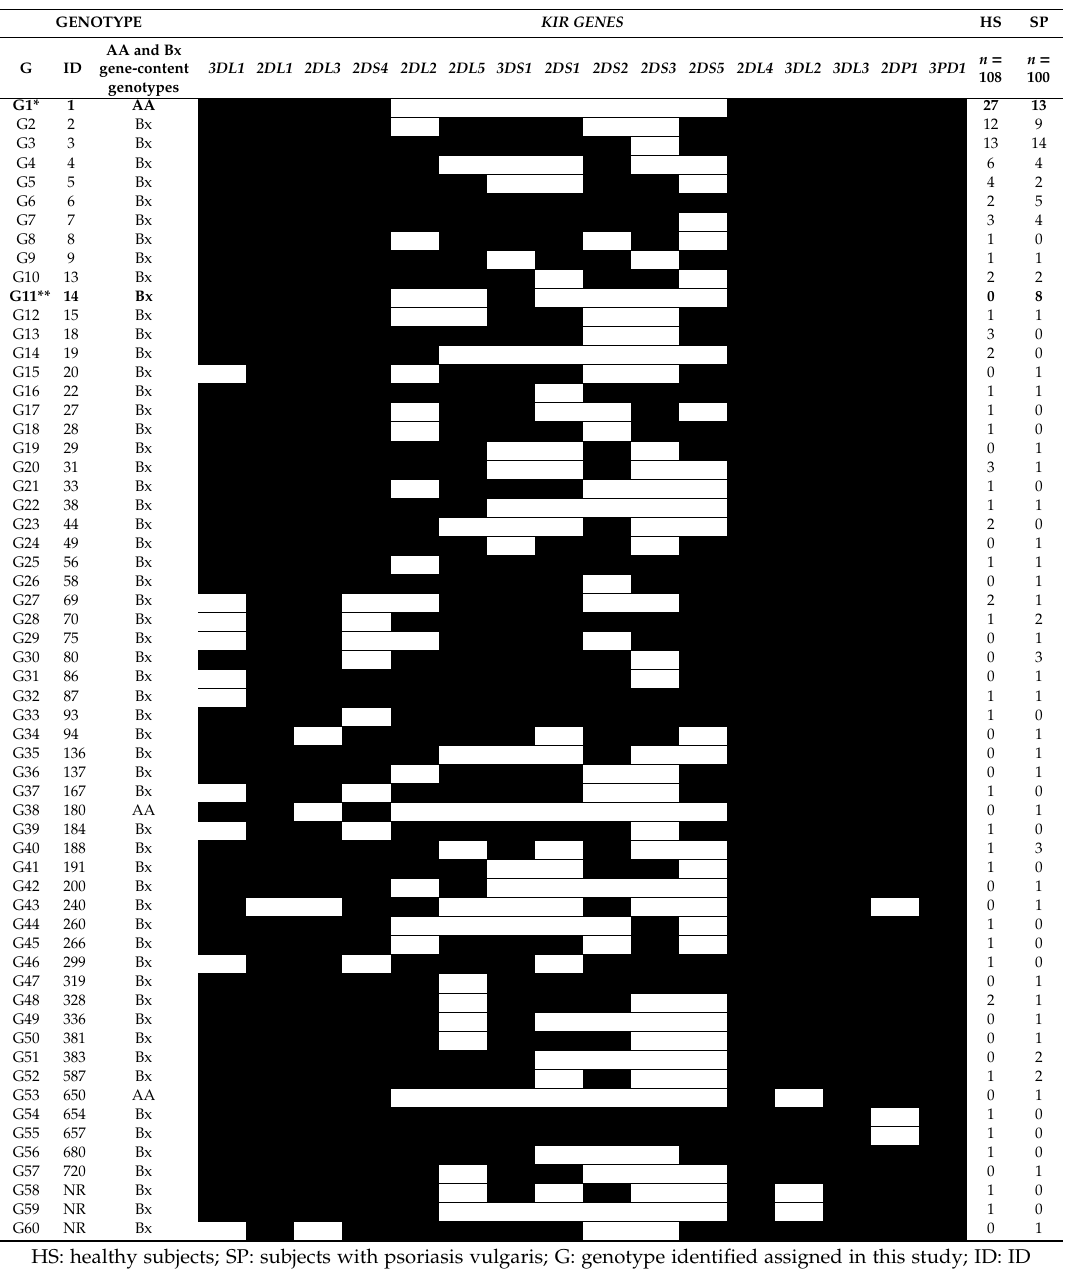
Table 2. KIR genotype profile of healthy subjects and subjects with psoriasis